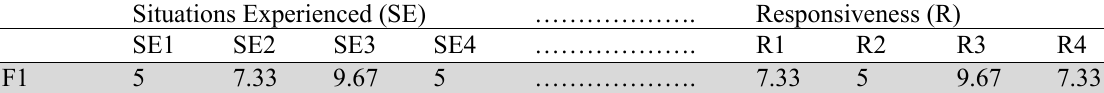
Table 7 Showing Crisp Criteria Importance Weights for Manager 1 Situations Experienced (SE)